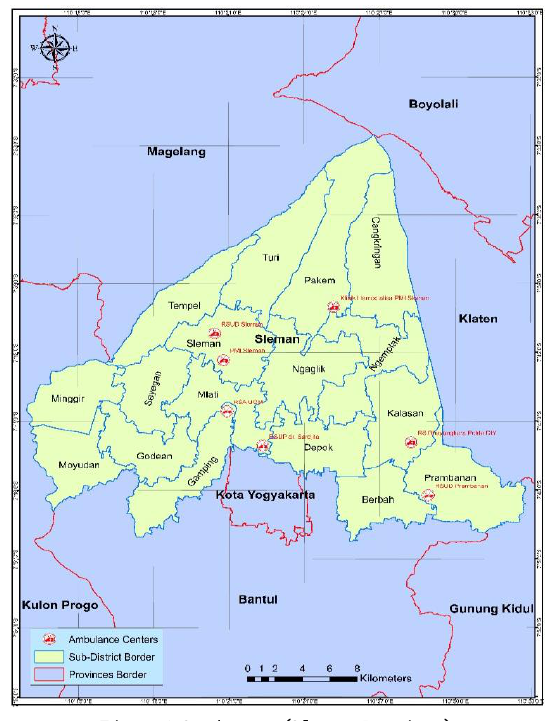
Figure 1 Study area (Sleman Province).